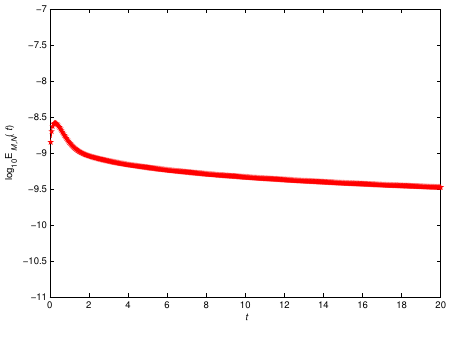
Figure 3. log 10 E M,N ( t ) vs t of scheme (3.5) for